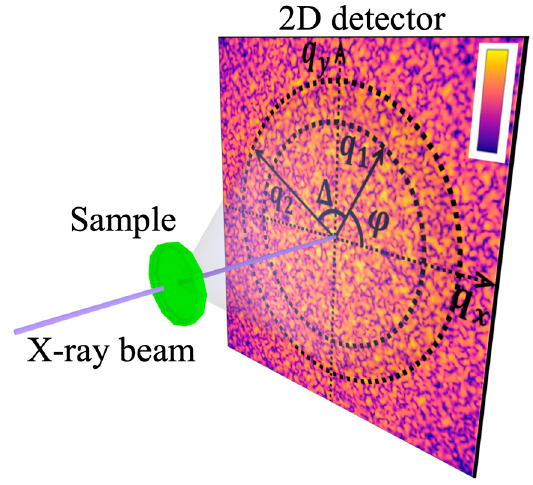
Figure 4. Scheme of an X-ray di ff raction experiment in transmission geometry. The focused X-ray beam can probe di ff erent spatial positions on the sample. Di ff raction pattern recorded by a 2D detector positioned behind the sample and polar coordinate system for evaluation of the angular cross-correlation function C ( q 1 , q 2 , ∆ ) are shown. The intensity of the di ff raction pattern is coded by color.